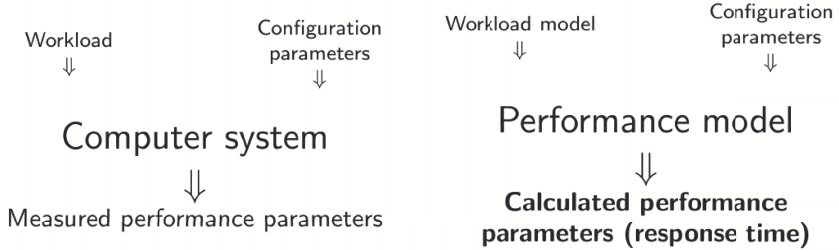
Figure 1. A diagram of the response time measurement process (difference between real computer system and performance